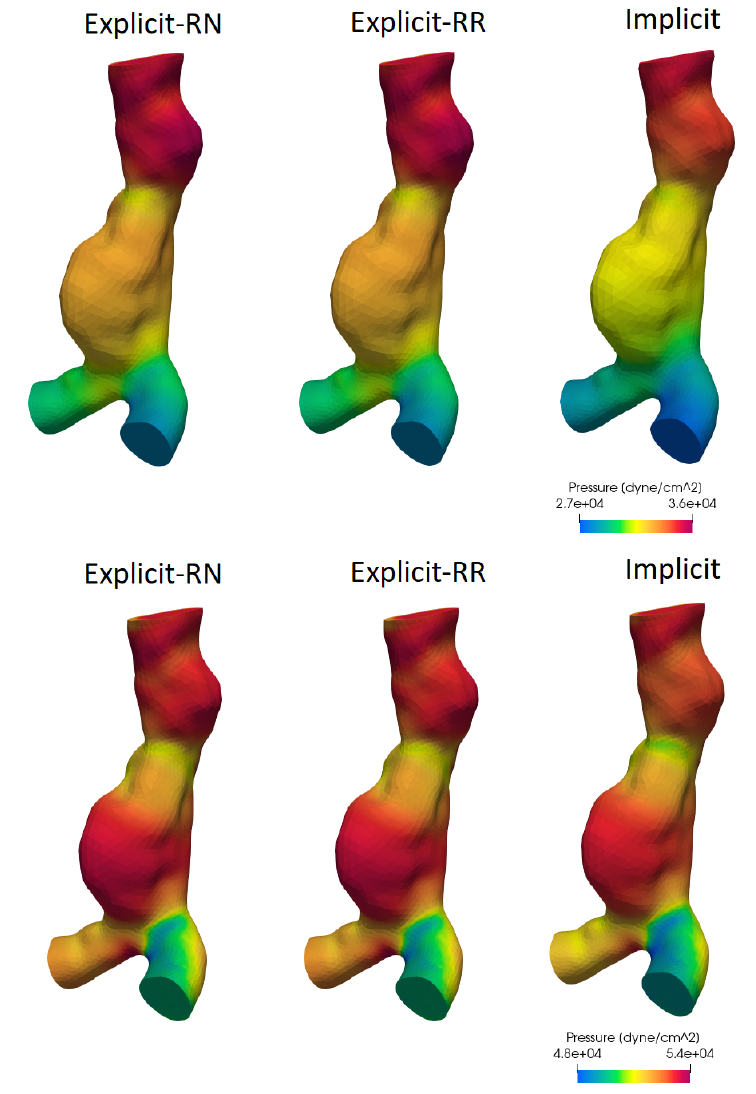
Figure 3. Pressure field for the AAA simulation. Top: t = 0.05 s; Bottom: t = 0.1 s. Test